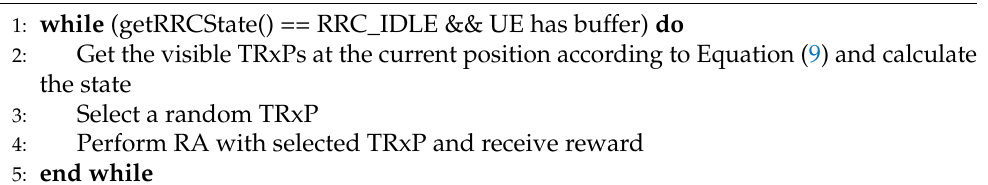
Algorithm 4 Random TRxPs Selector Algorithm: